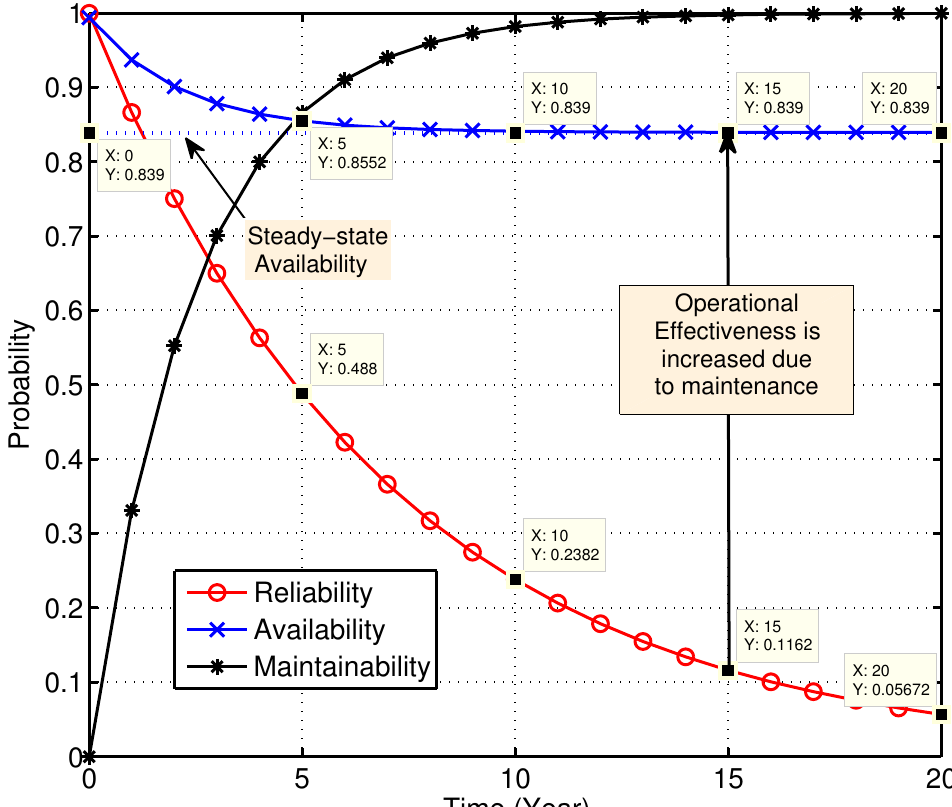
Figure 8. Reliability, Availability, and Maintainability curves for the